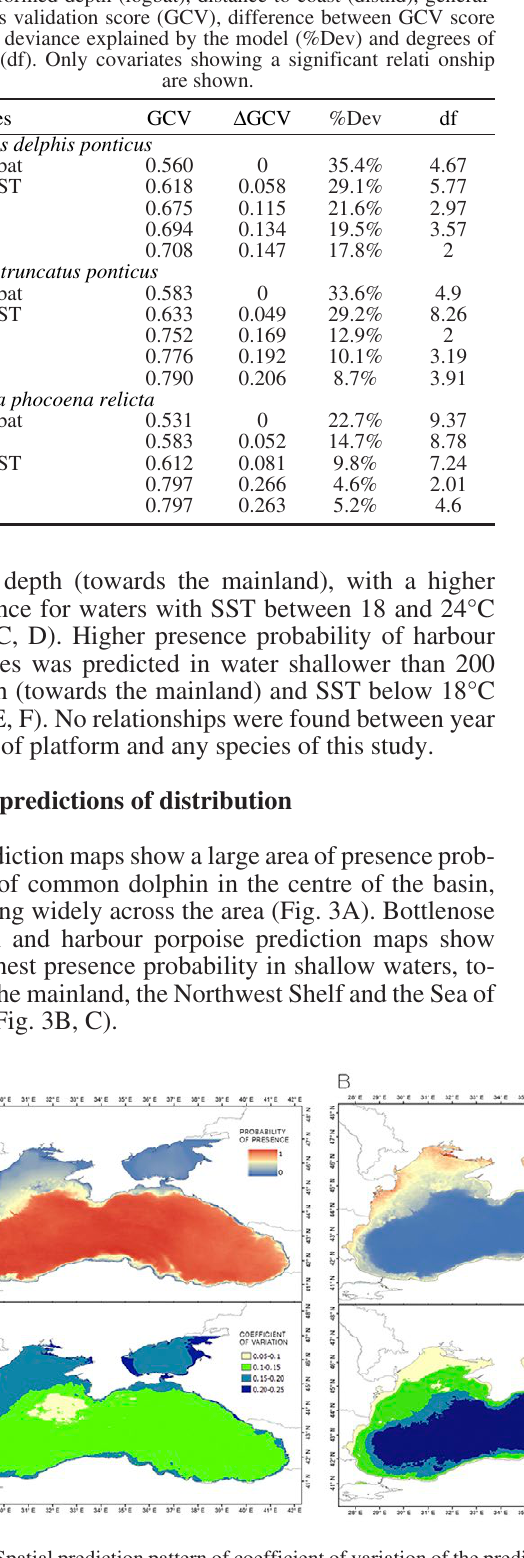
Fig. 3. – Spatial prediction pattern of coefficient of variation of the prediction models after 200 bootstrap resamples for (A) Black Sea common dolphin ( Delphinus delphis ponticus ), (B) Black Sea bottlenose dolphin ( Tursiops truncatus ponticus ) and (C) Black Sea harbour porpoise ( Phocoena phocoena relicta ) probabilities during the summer season of